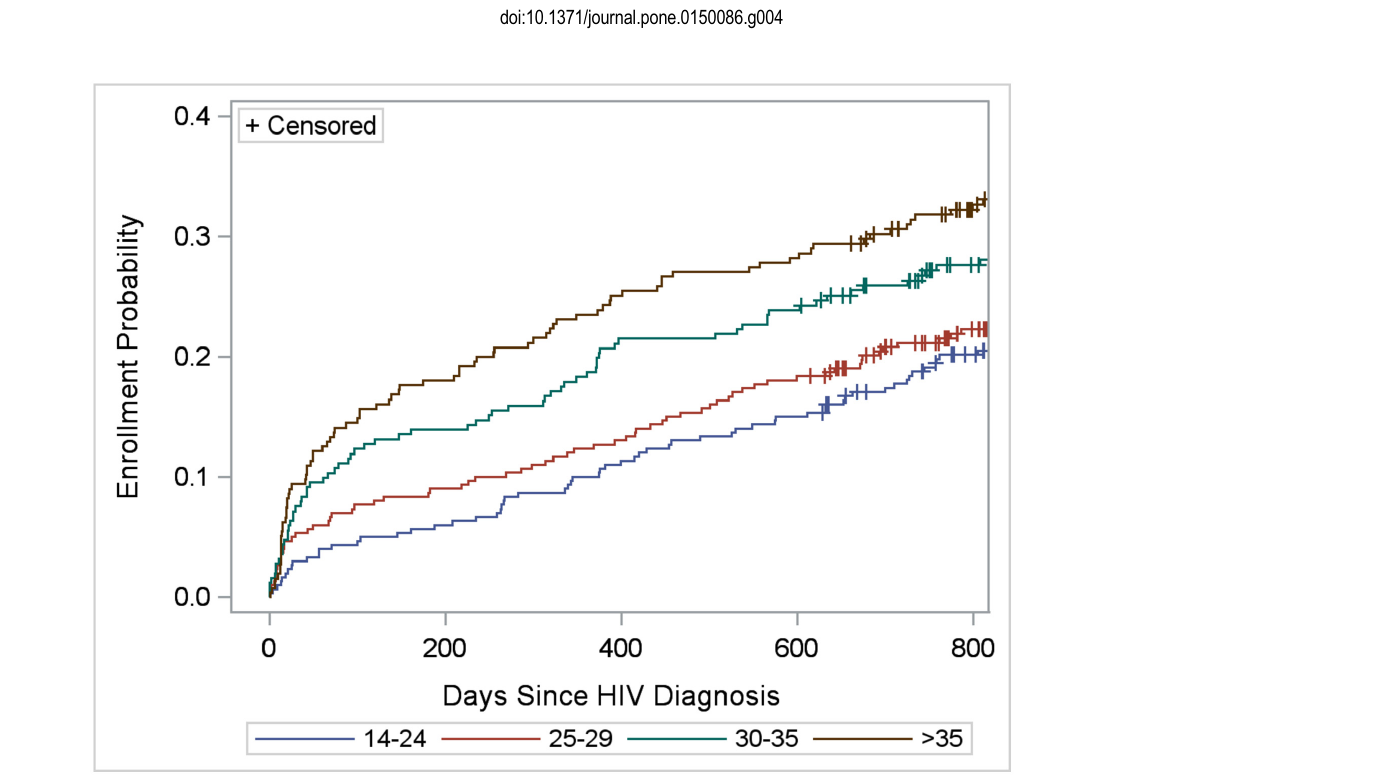
PLOS ONE | DOI:10.1371/journal.pone.0150086 February 24,